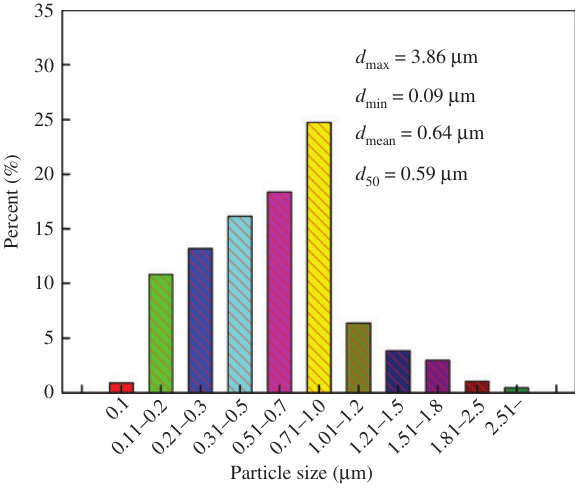
Figure 4: The particle size distribution of the prepared CeO by ultrasonic spray pyrolysis of CeCl